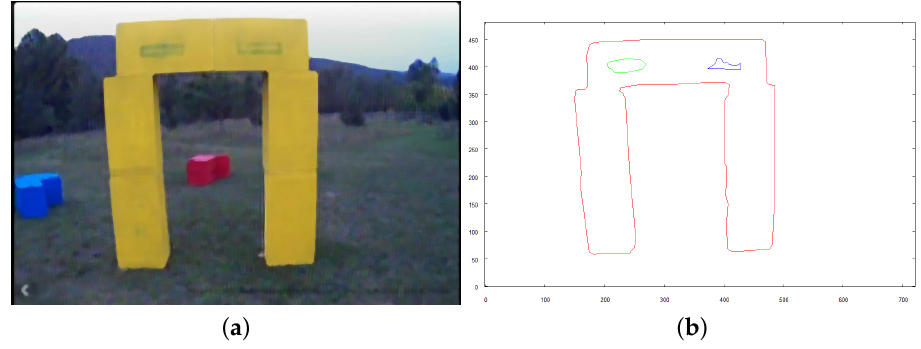
Figure 28. Image of FRONT side of structure. ( a ) preprocessed image; ( b ) vectorized image.